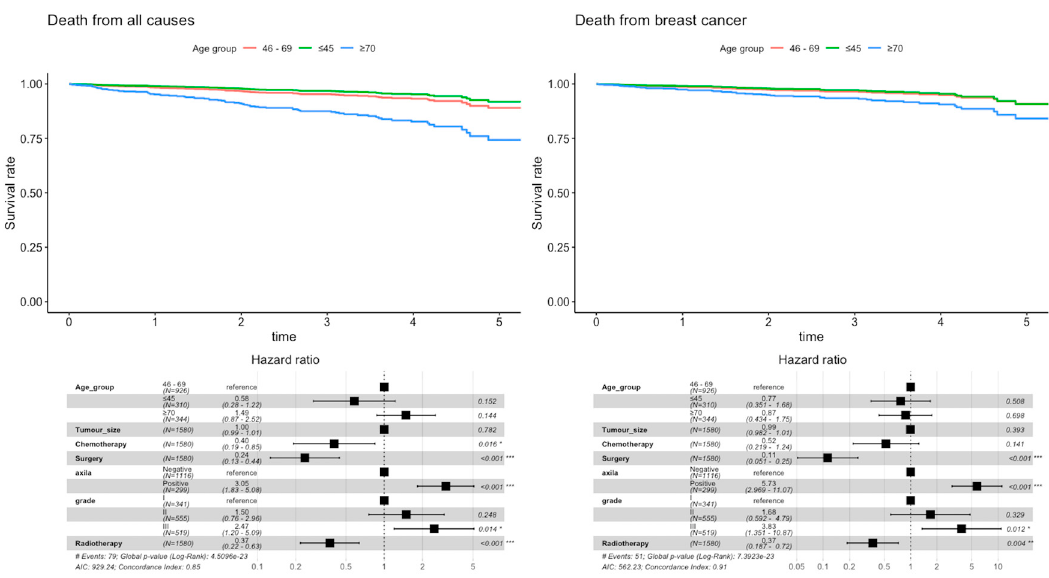
Figure 1. All-cause mortality and BC-specific mortality by age group (* p < 0.05, *** p < 0.001) .